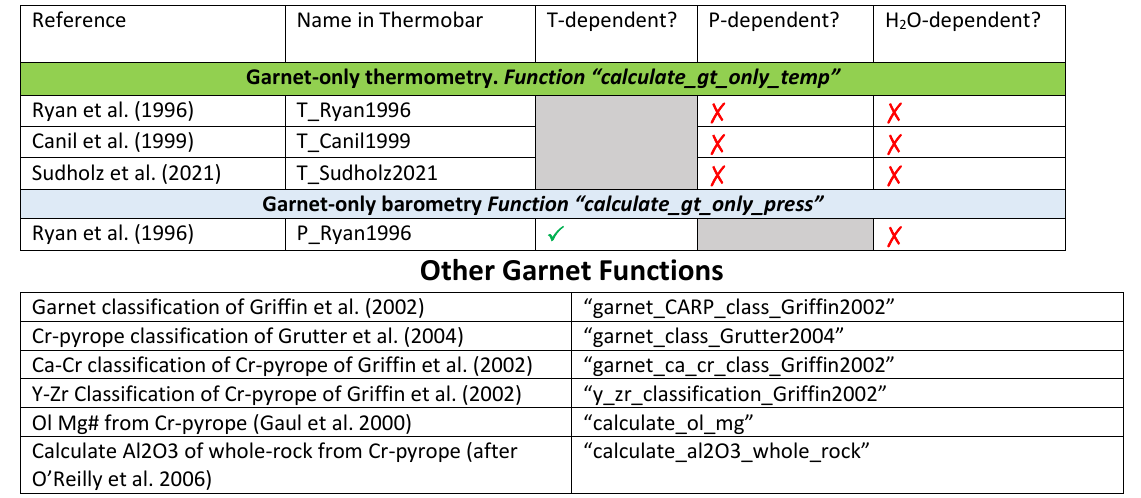
Table A8: Summary of equations for Garnet calculations. From: Ryan et al. 1996, Canil 1999, Sudholz et al. 2021, Griffin et al. 2002, Grütter et al. 2004, Gaul et al. 2000 and O’Reilly and Griffin